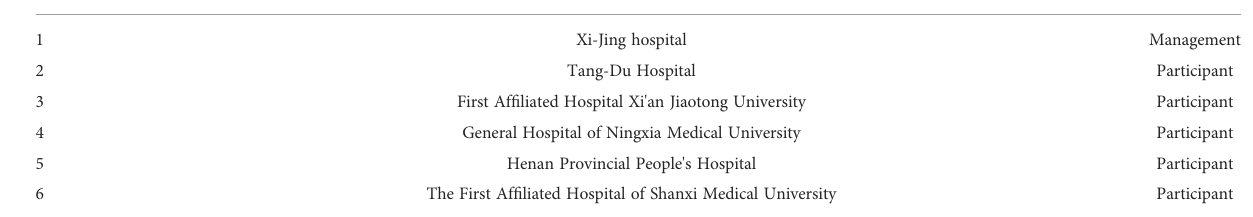
TABLE 2 The perioperative follow-up data were sorted and